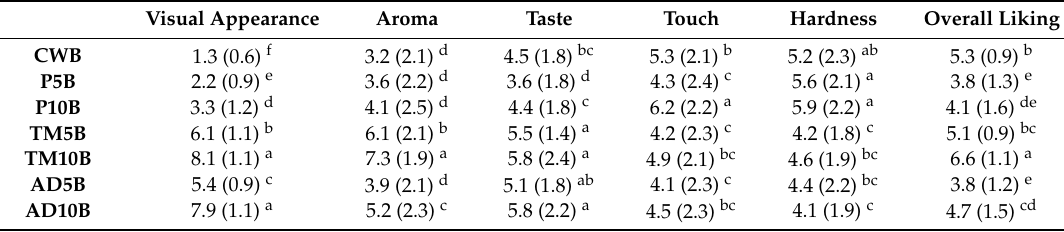
Table 6. Hedonic data of liking study ( n =